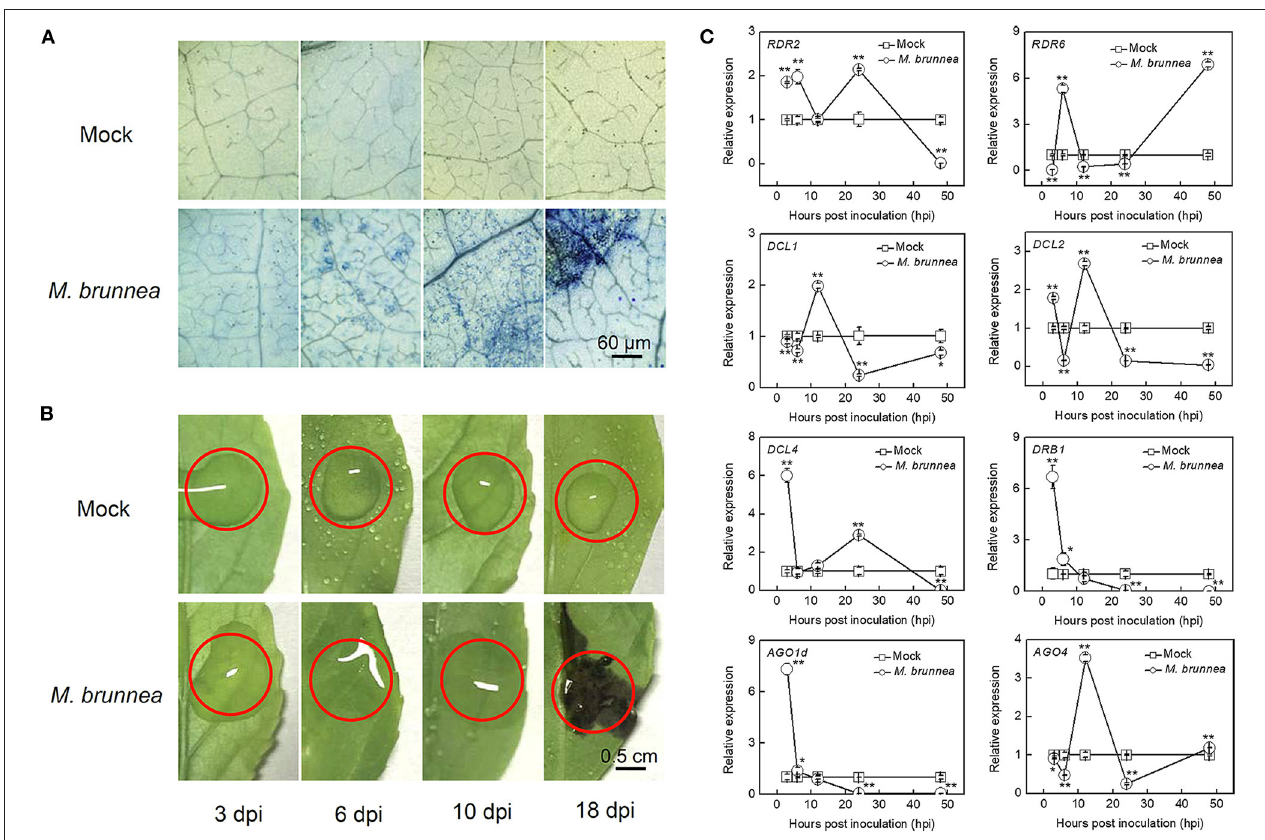
FIGURE 1 | Disease symptoms and gene expression of poplar leaves at different time points post Marssonina brunnea inoculation. (A) Light micrographs of leaf pieces stained with aniline blue and (B) photographs at 3, 6, 10, and 18 days postinoculation (dpi). Area within red cycle in (B) is inoculated; bar = 60 µ m in (A) or 0.5cm in (B) . (C) The expression of microRNA biosynthetic genes at 3, 6, 12, 24, and 48h postinoculation (hpi). Leaf samples were collected from the inoculated leaves with M. brunnea and mock inoculations were performed with sterile ddH 2 O alone as a negative control. The square indicates mock treatment and the cycle represents M. brunnea inoculation, with positive and negative error bars. The results are presented as mean values ± SD; n = 3. Asterisks represent significant differences in gene expression between treatments of mock and M. brunnea inoculation, according to Duncan’s test. * P < 0.05; ** P < 0.01. RDR, RNA-dependent RNA polymerase; DCL, dicer-like protein; DRB, double-stranded RNA-binding protein; AGO, argonate